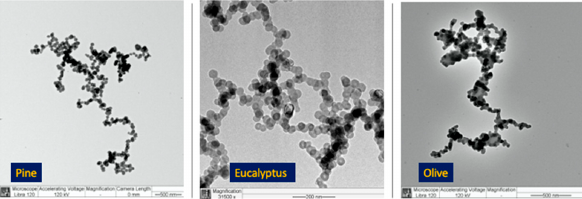
Figure 4. Sample TEM images representing the Pine, Eucalyptus, and Olive fuels analyzed.